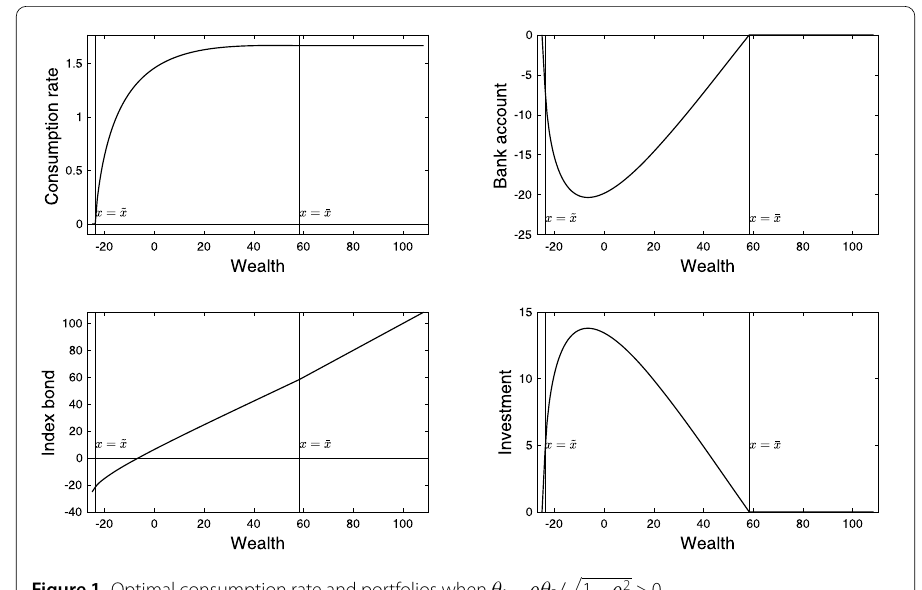
Figure 1 Optimal consumption rate and portfolios when θ 1 – ρθ 2 /